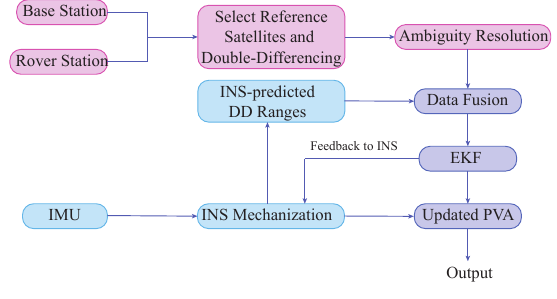
Figure 1: The system diagram of RTK/INS integration after the alignment phase.